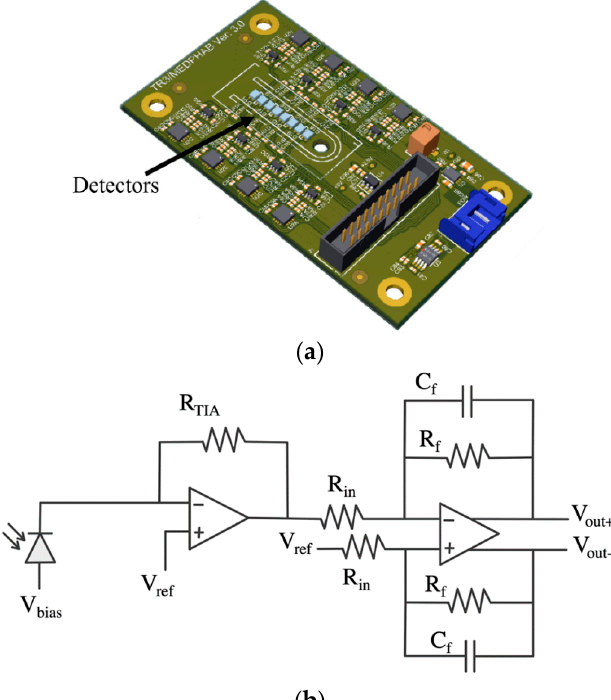
Figure 8. ( a ) PCB of the detection system. Each SiPM has its own TIA and LPF. Detectors are placed in the centre of the board, allowing for the fitting of opto-mechanical components: micro-filters and casing. ( b ) Schematic of one of the channels on the PCB. Input is the photocurrent flowing from the SiPM, turned into a voltage with the TIA, and the filtered stage is differential, removing common mode noise.